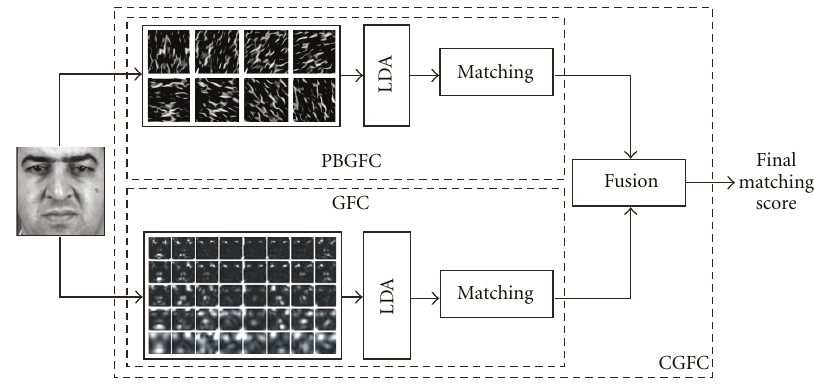
Figure 8: Block scheme of the Complete Gabor-Fisher Classifier.